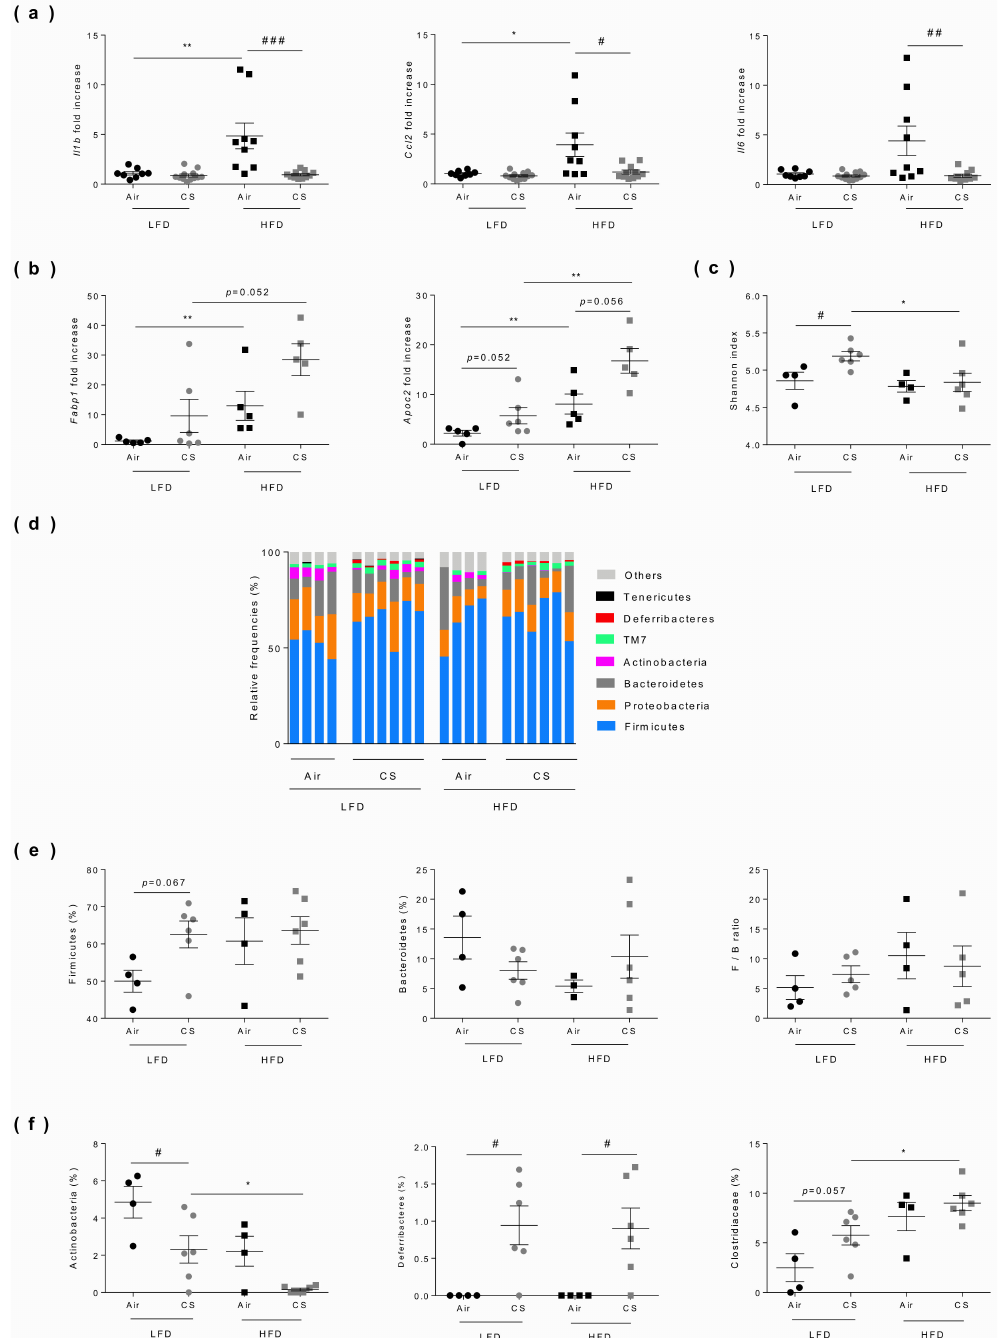
Figure 4. Chronic cigarette smoke (CS) exposure limits obesity-associated gut inflammation, exacerbates fatty acid metabolism and modulates caecal microbiota. (a) The expression levels of Il1b, Il6, and ccl2 genes evaluated in ileum by RT-qPCR ( n = 8–12 mice per group). (b) The expression levels of Fabp1 and Apoc2 genes evaluated in ileum by RT-qPCR ( n = 5–6 mice per group). (c) Shannon diversity index was determined ( n = 4–6 mice per group). ( d ) Relative abundance of bacterial 16S rRNA genes found in caecal content classified at phyla level. Individual profiles are shown for each group of mice ( n = 4–6 mice per group). (e) Relative frequencies of Firmicutes, Bacteroidetes and Firmicutes / bacteroidetes ratio found in caecal contents. ( f ) Abundance of Actinobacteria (left panel), Deferribacteres (middle panel) and Clostridiaceae (right panel) found in caecal contents. Data are expressed as individual and mean ± SEM values. * p < 0.05, ** p < 0.01, *correspond to diet e ff ect (HFD vs. LFD), # p < 0.05, ## p < 0.01, ### p < 0.001, #correspond to CS e ff ect (CS vs. Air). See Table S2 for detailed